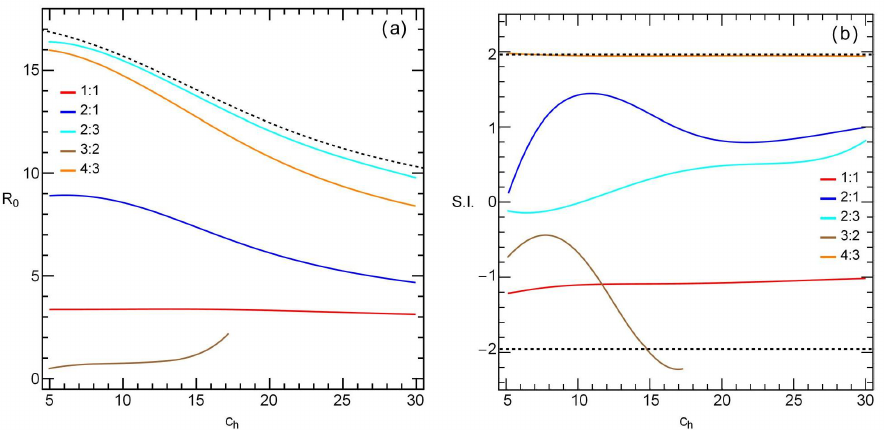
Fig. 4. Panel (a), left: the ( R 0 ; c h ) characteristic curves of the orbital families; panel (b), right: evolution of the stability index S.I. of the families of periodic orbits shown in panel (a). The black horizontal dashed lines at –2 and +2 delimit the range of S.I. for which the periodic orbits are stable. (i.e, the 1:1 and 3:2 resonant orbits) initial conditions as position-velocity